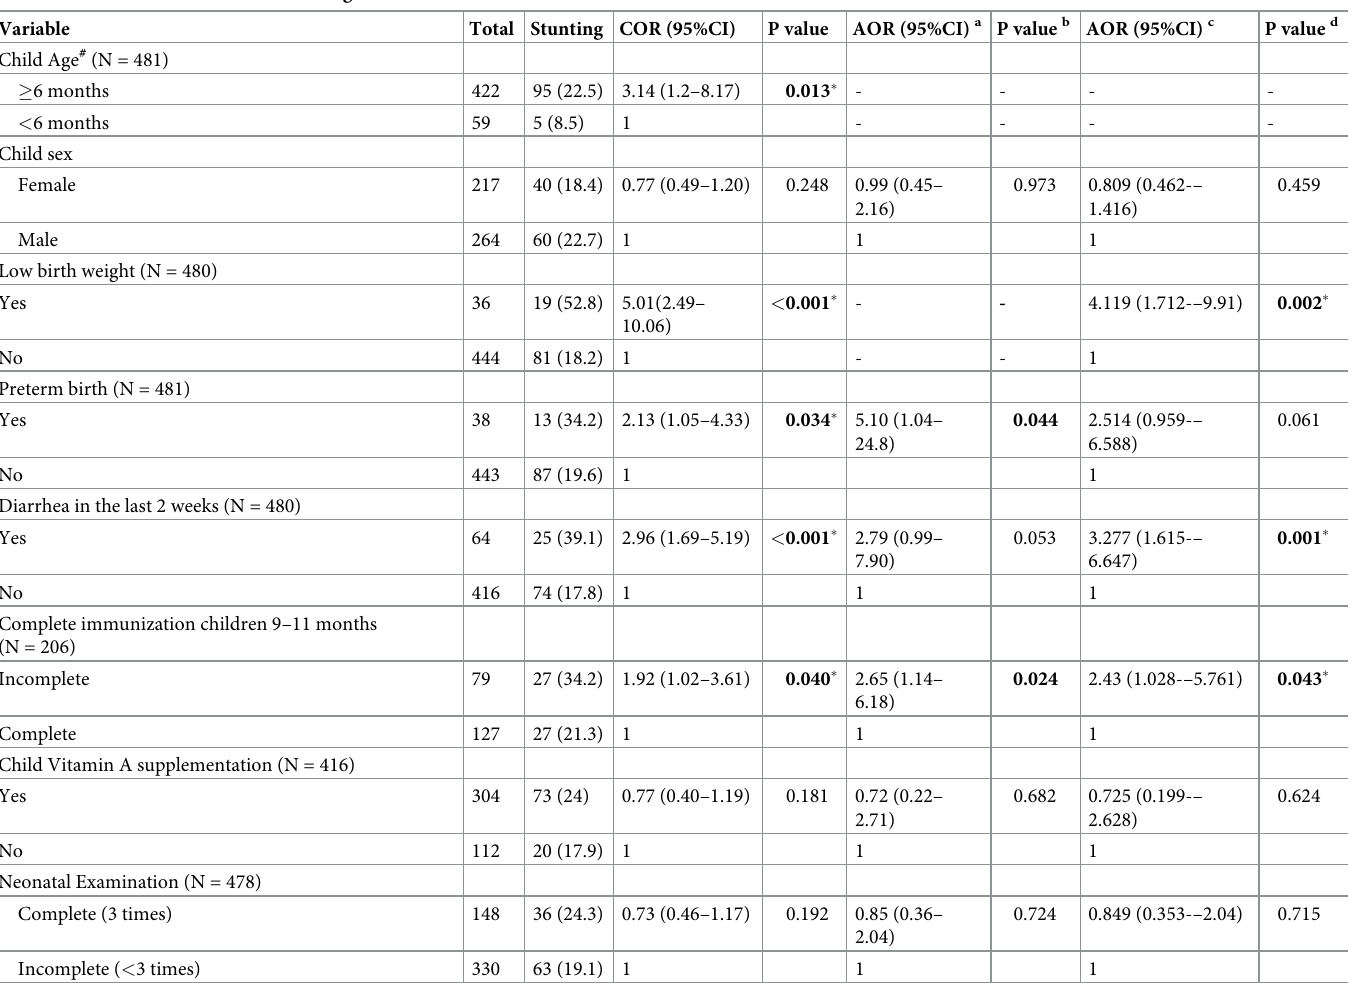
Table 3. Child characteristics and